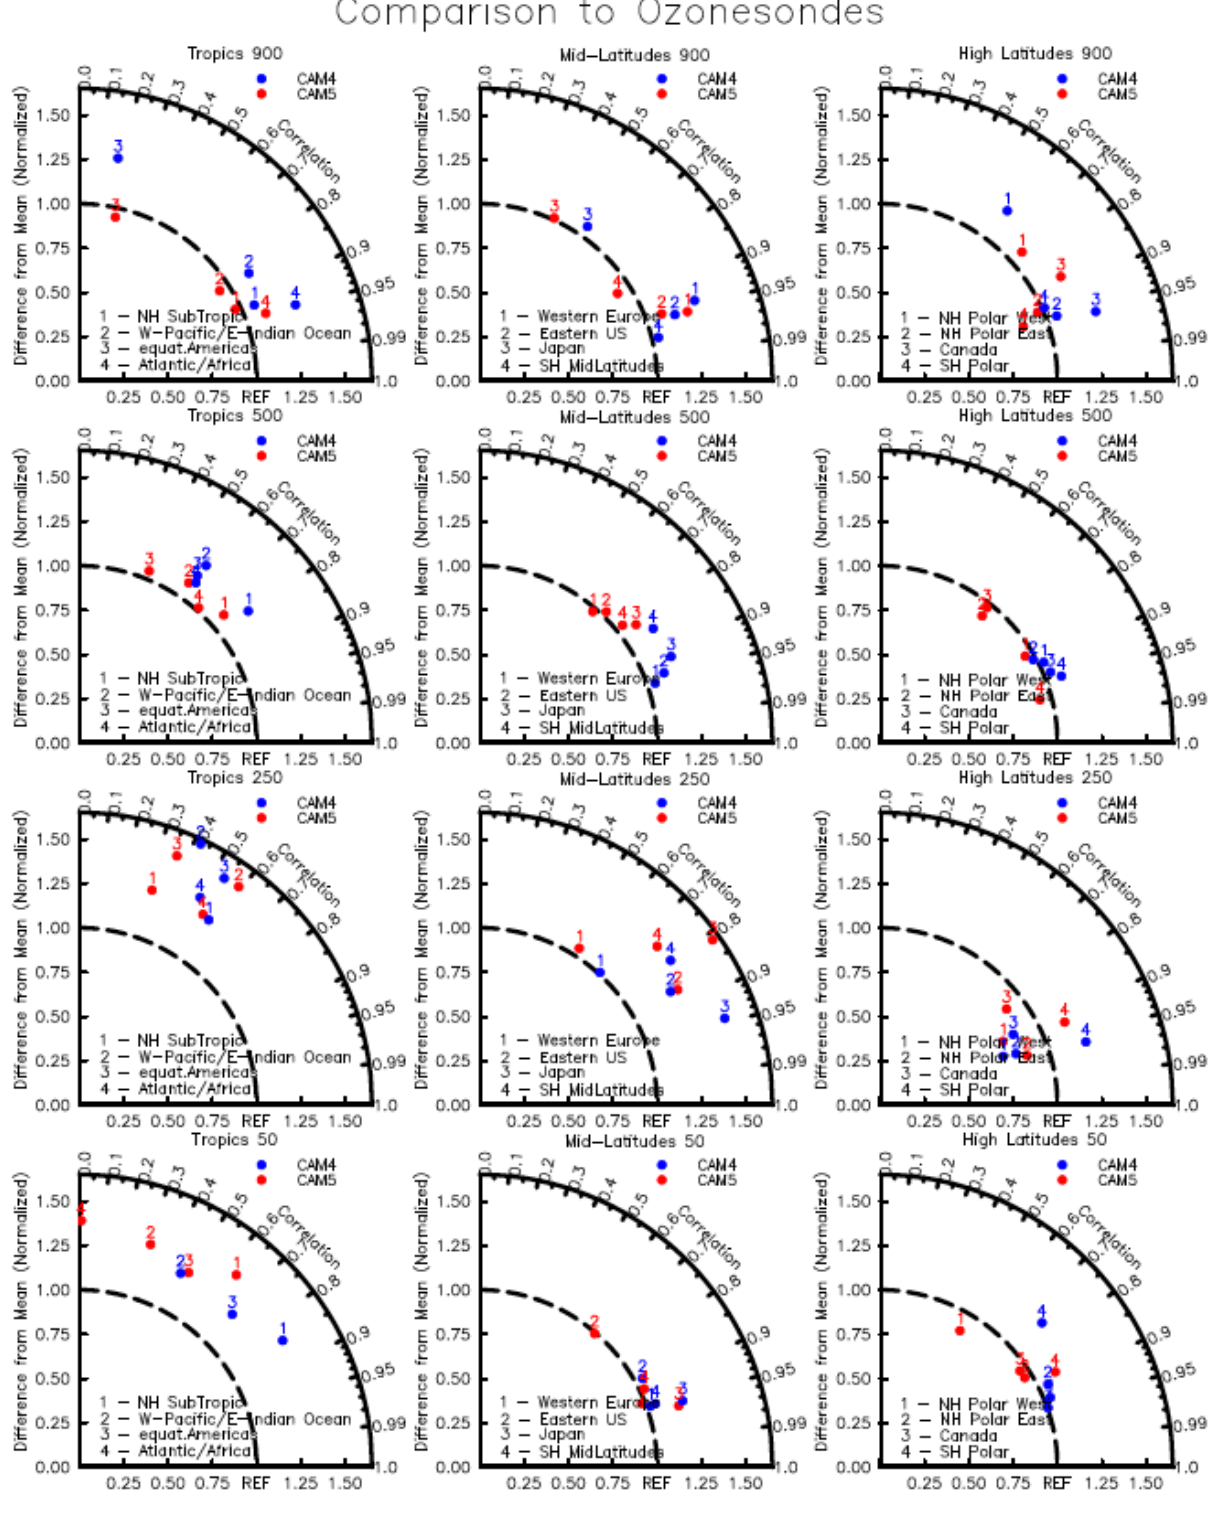
Figure 1. Taylor diagram of modeled background ozone from the control runs against ozonesonde climatology for four pressure levels and three latitudinal regions. REF along the abscissa denotes the observations while the radial distance describes the normalized bias. The correlation for the seasonal cycle is described along the